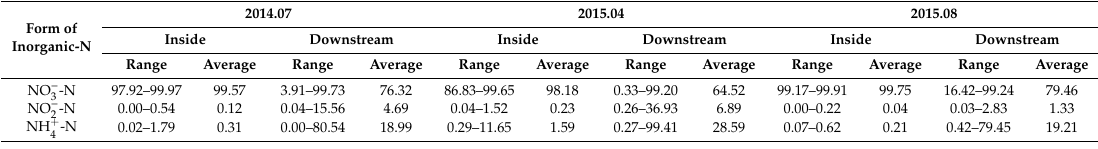
Table 4. Ratios of NO downstream groundwater (%).